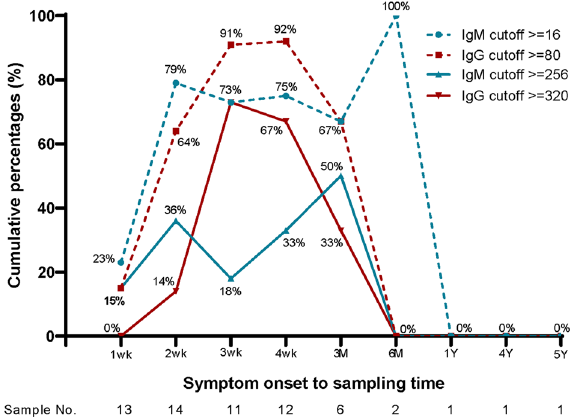
Figure 3. The cumulative percentage for positive rate by symptom onset to sampling time. When a 1:16 or higher IgM titer was set as the cut-off, 79% of the patients were positive 2 weeks after the onset of symptoms and remained positive until the sixth month from the onset of symptoms. When a 1:80 or higher IgG titer was set as the cut-off, up to 92% of the patients were positive 4 weeks after the onset of